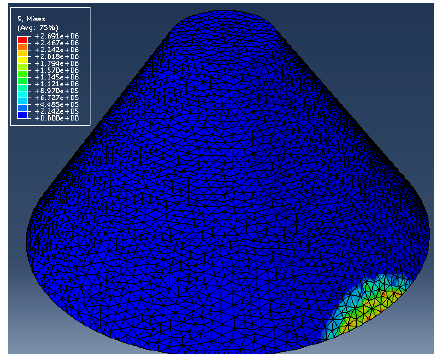
Fig. 5. Von misses composite stress contour in the frustum building while explosion strikes the building on the ground